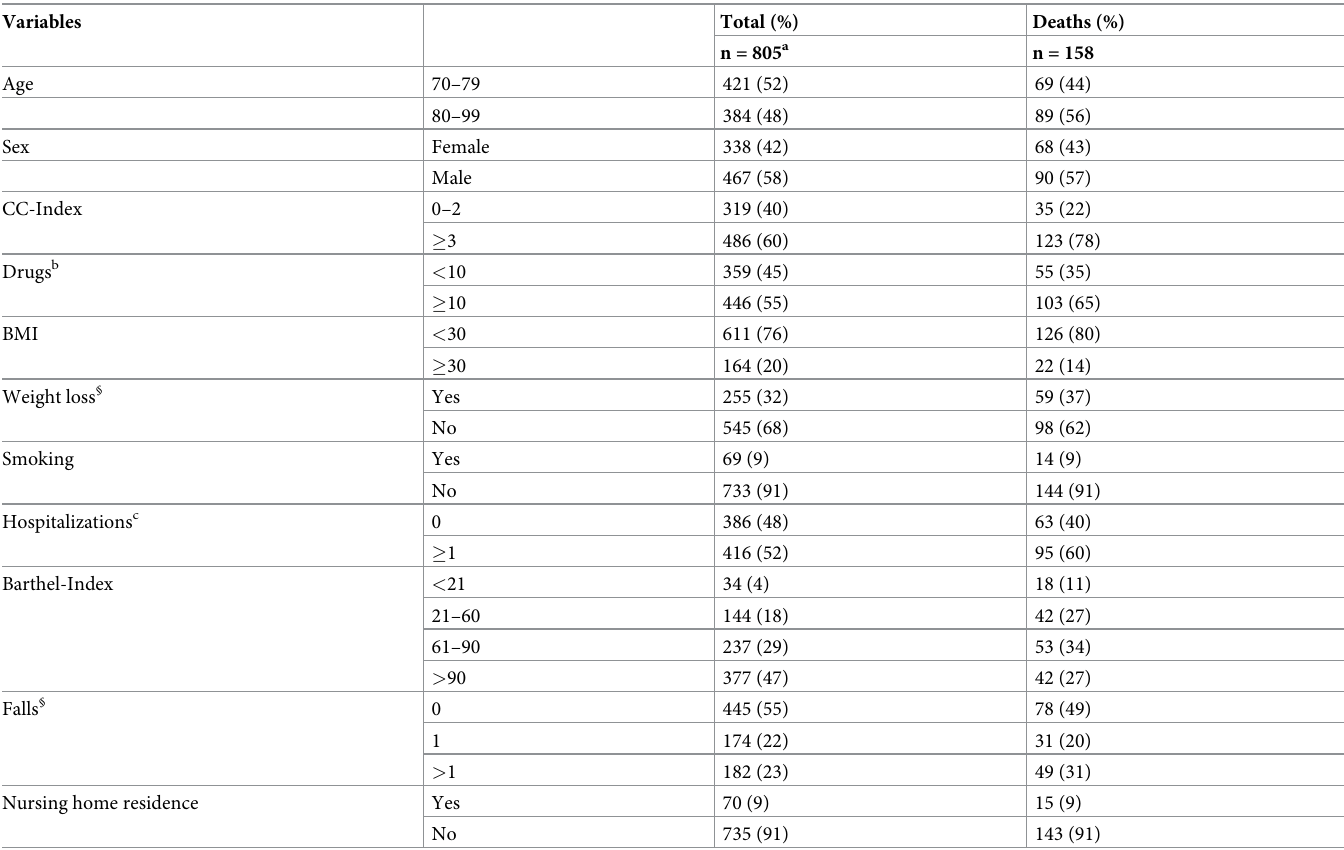
Table 1. Baseline characteristics of all participants and of those who died during